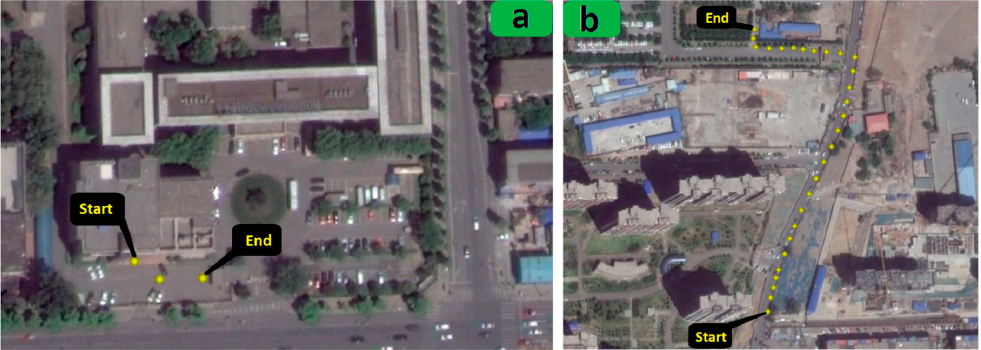
Figure 9. Examples of a curved trajectory. ( a ) A potential curved trajectory with minimum critical points; ( b ) A simple trajectory with a series of sample points recorded by GPS.